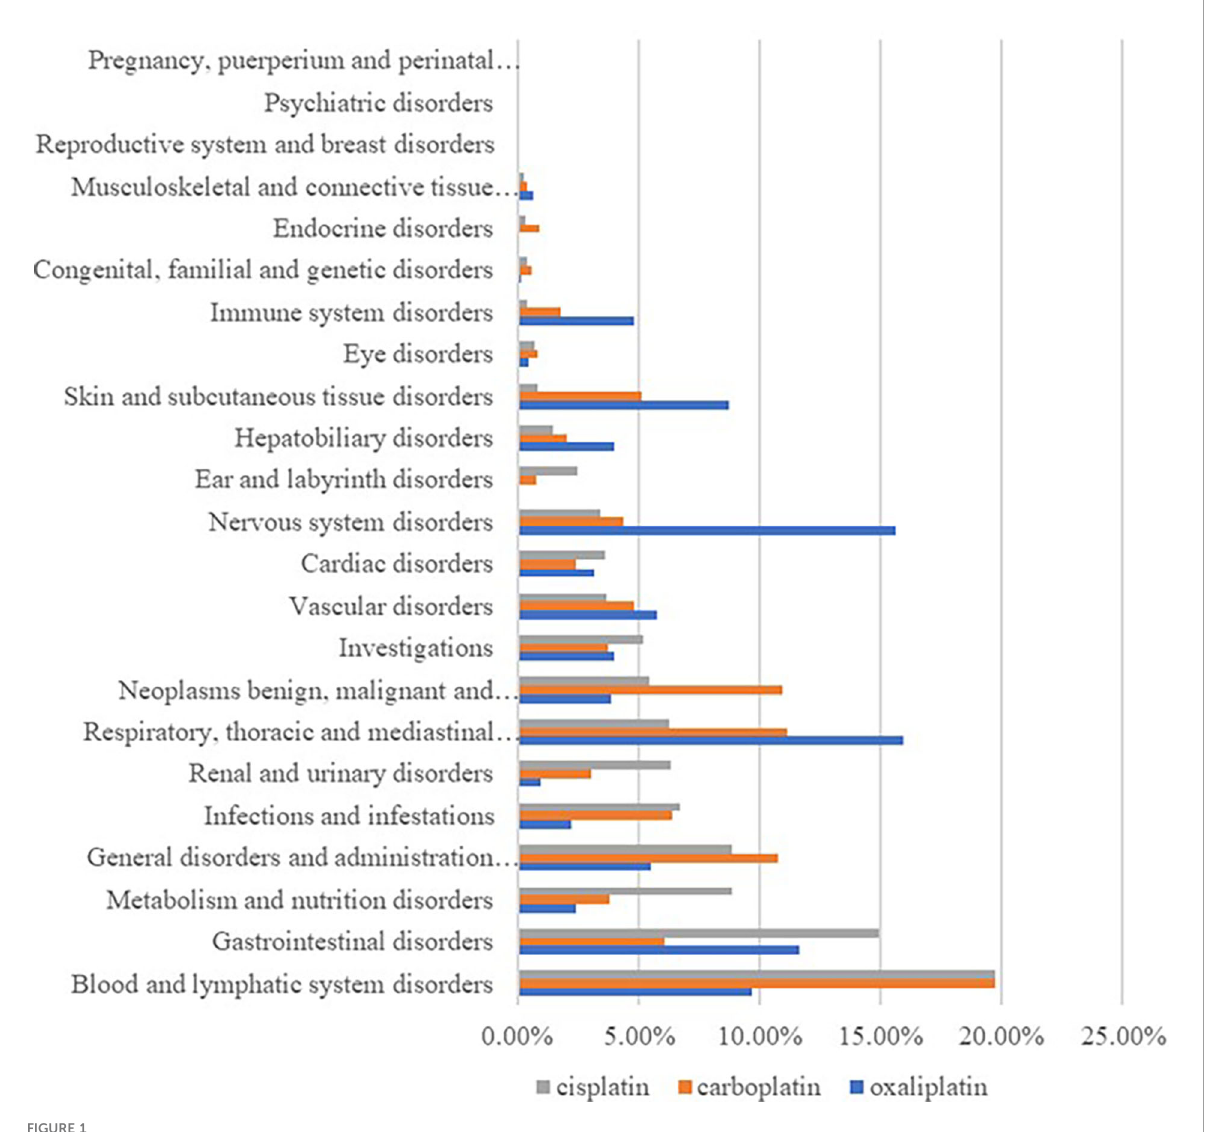
FIGURE 1 Proportion of reported cases of platinum drugs involving systemic